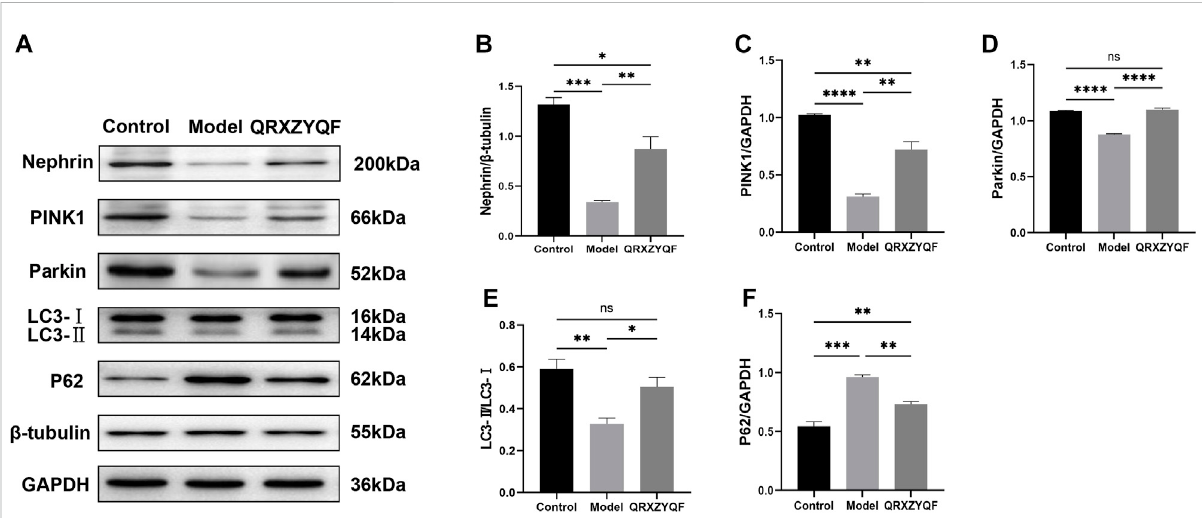
FIGURE 7 Western blot analysis of MPC5. ns P < .05, * p < .05, ** p < .01, *** p < .001, **** p < .0001. (A) The band of Nephrin, PINK1, Parkin, LC3 and P62; (B) Relative expression of Nephrin; (C) Relative expression of PINK1; (D) Relative expression of Parkin; (E) LC3-II/LC3-I ratio; (F) Relative expression of P62.